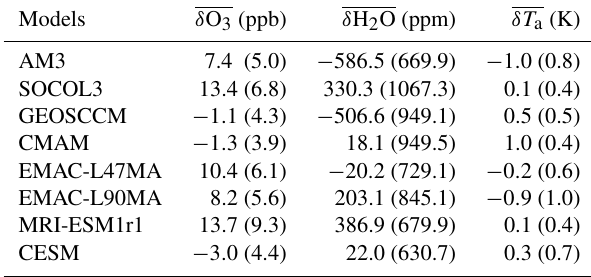
Table 3. Models’ bias in the tropical troposphere between 25 ◦ S and 25 ◦ N, and below 200hPa.